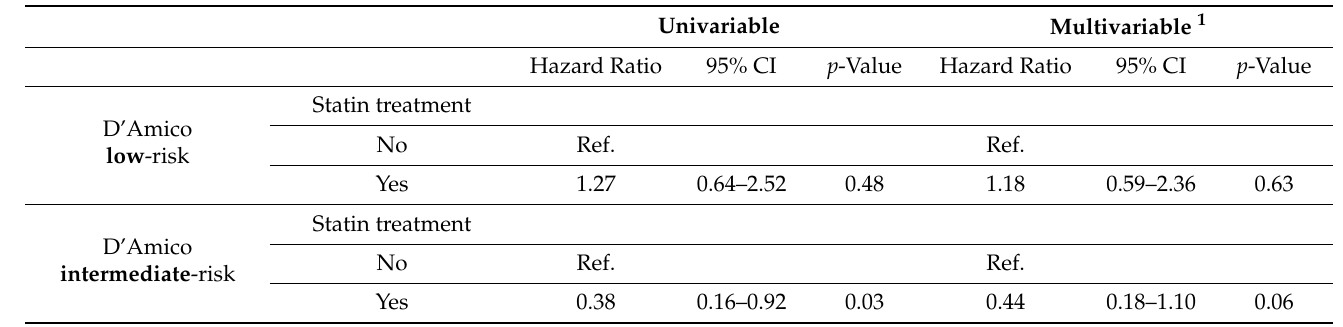
Table 4. Univariable and multivariable Cox regression models predicting biochemical recurrence among LDR-treated patients (low and intermediate), according to statin use. Univariable Multivariable 1 Hazard Ratio 95% CI p -Value Hazard Ratio 95% CI p -Value